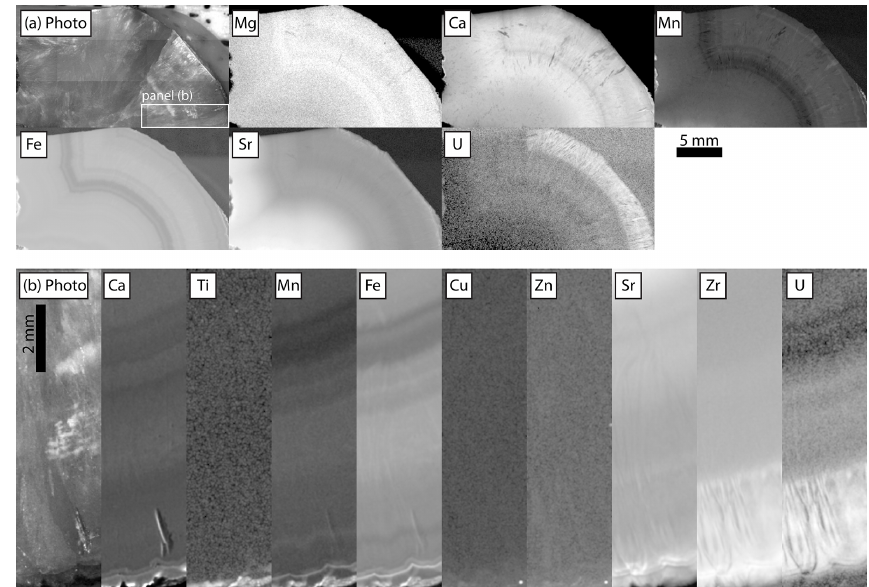
Figure 19. Relative intensities of emission regions for each element detected in Turkana dolomite. Each panel is adjusted in terms of gamma and contrast to emphasize gradients between texture: (a) no incident radiation filter, imaged at 25µm pixels, with 120ms per pixel dwell time and 1.5SD Gaussian blur, and the box indicating the region that was re-mapped with the filter shown in (b) . (b) Incident radiation filtered using 100µm Al, 50µm Ti, 20µm Cu foil, imaged at 20µm pixels with 900ms per pixel dwell time and 1.5SD Gaussian